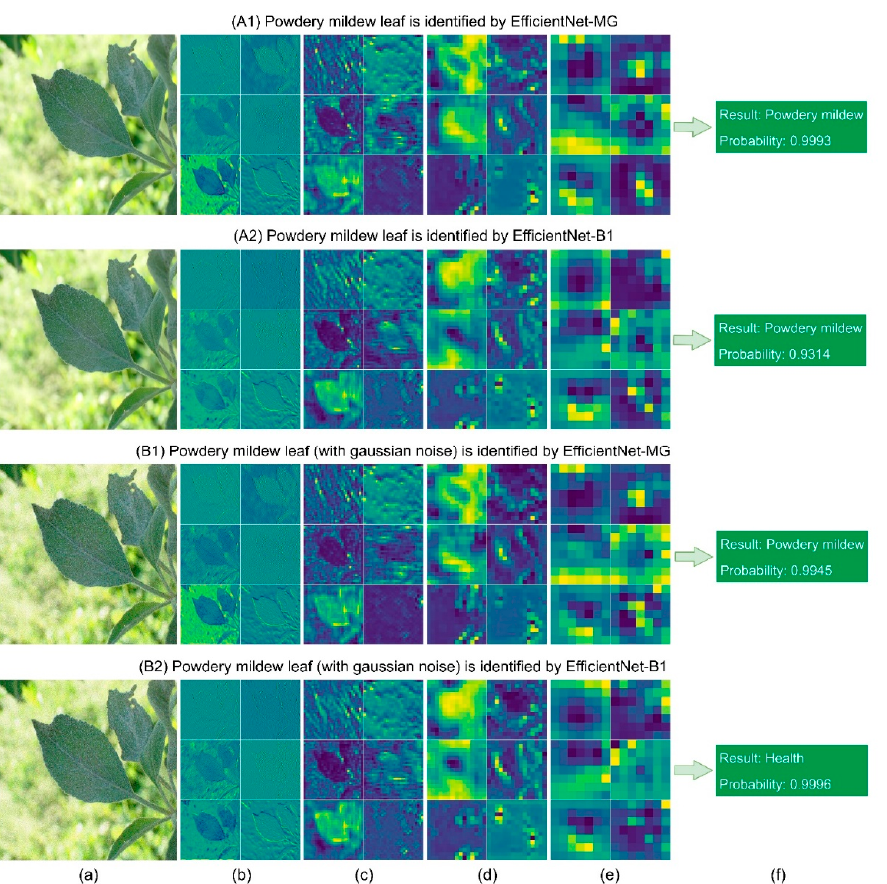
Figure 15. EfficientNet-MG and EfficientNet-B1 identification results with feature visualization: ( a ) original image; ( b ) L1; ( c ) L2; ( d ) L3; ( e ) L4; ( f ) identification results.